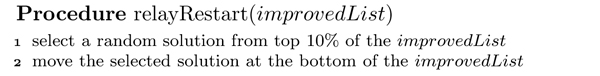
Relay-restart algorithm. Spiral Search framework: pseudocode of Procedure relayRestart.